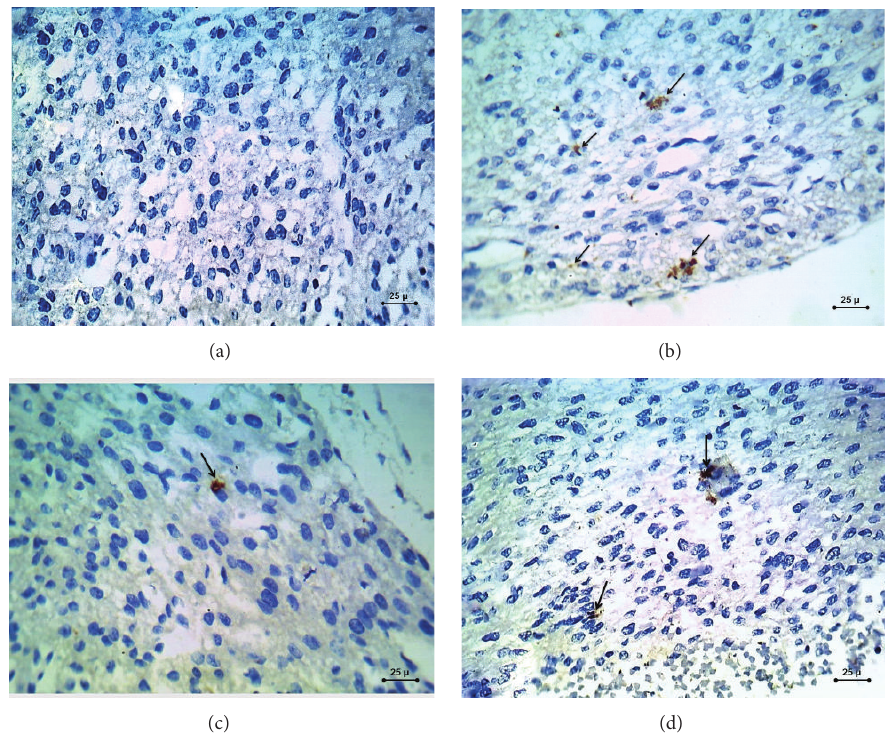
Figure 2: Photomicrograph of caspase-3 immunohistochemical staining ( × 400) sections in the fetal myocardium. (a) control group. (b) STZ-induced DM group. (c) STZ-induced DM treated with zinc group. (d) STZ-induced DM treated with insulin group. Shown is positive brownish cytoplasmic immunohistochemical staining with caspase-3 in group (b) which seems to be downregulated in both group (c) and group (d); this brownish cytoplasmic immunohistochemical staining is almost absent in group (a).